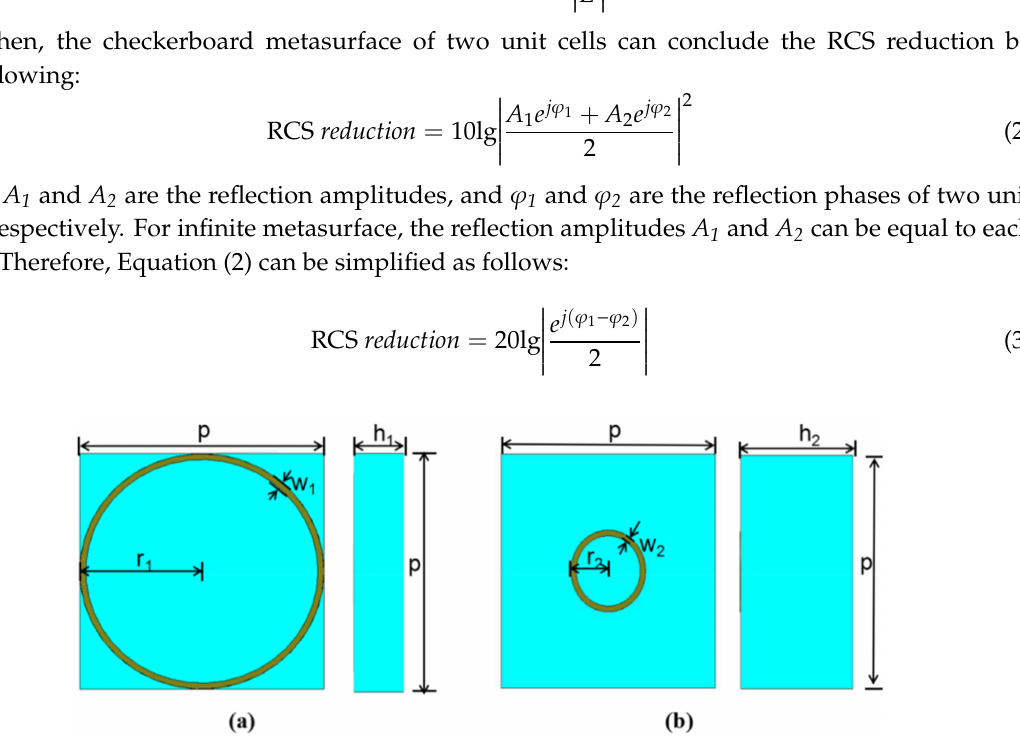
Figure 1. The model and geometry of the unit cells: ( a ) the top view and side view of the unit cell 1, and ( b ) the top view and side view of the unit cell